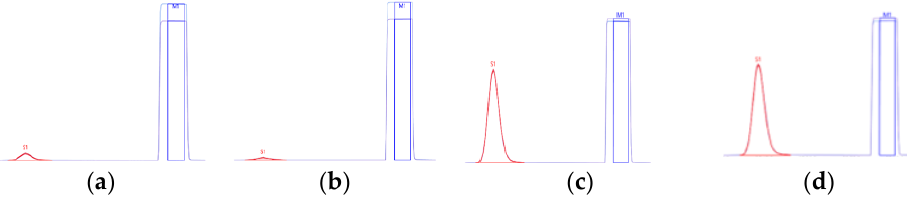
Figure 2. Chromatograms of blank (empty) tin capsule ( a ), MeOH/DCM prewashed tin capsule ( b ), and standard chlorantraniliprole ( c ) and standard cyantraniliprole ( d ) in EA – IRMS. Square-shaped peaks indicate reference CO 2 .